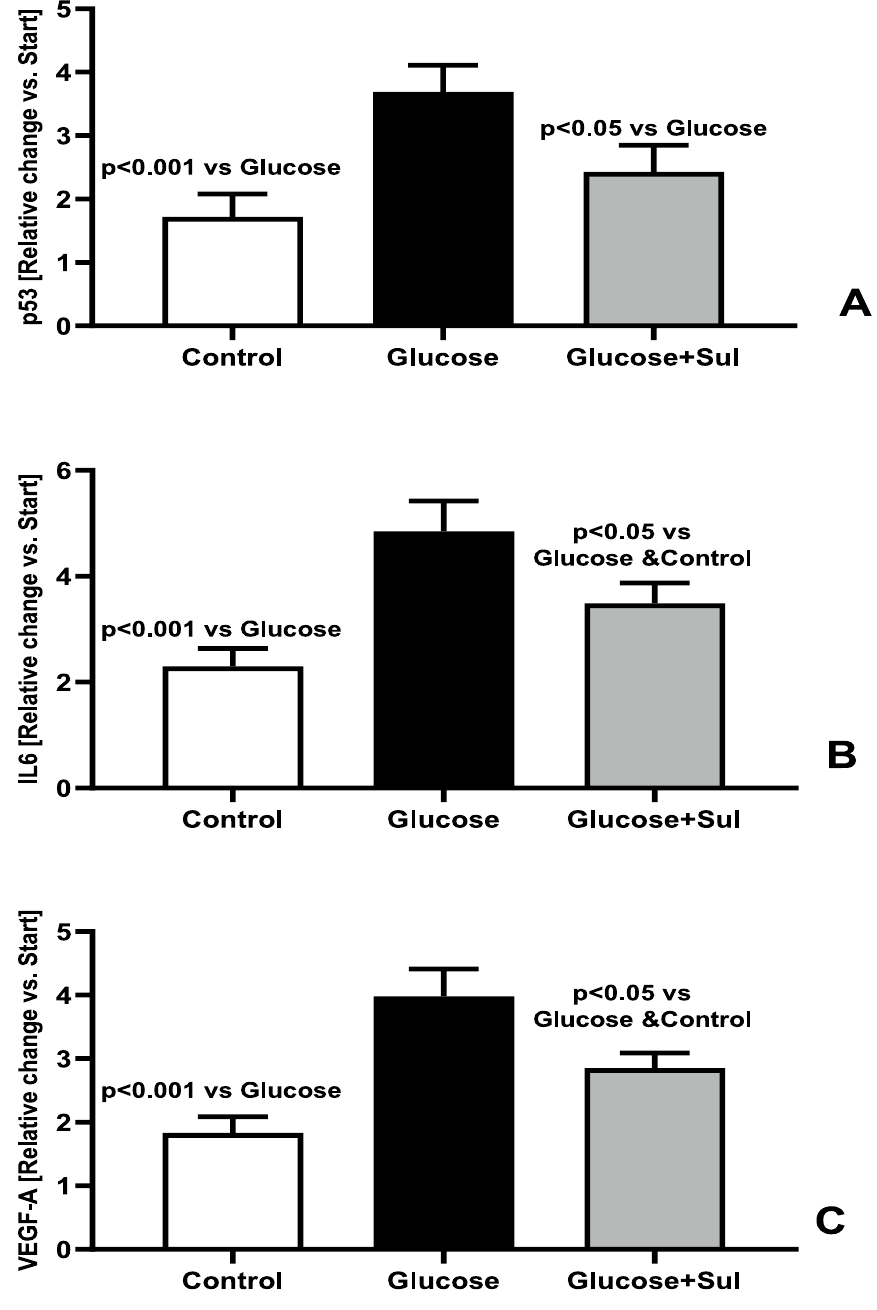
Figure 3. Expression of genes for p53 ( A ), IL6 ( B ) and VEGF-A ( C ), presented as change versus start of the experiment, in HREC at the end of the replicative senescence in control medium (Control) medium supplemented with glucose 20 mmo/l (Glucose) and medium supplemented with glucose 20 mmol/L and Sulodexide 0.5 LRU/mL (Glucose + Sul) (n = 8) (ANOVA